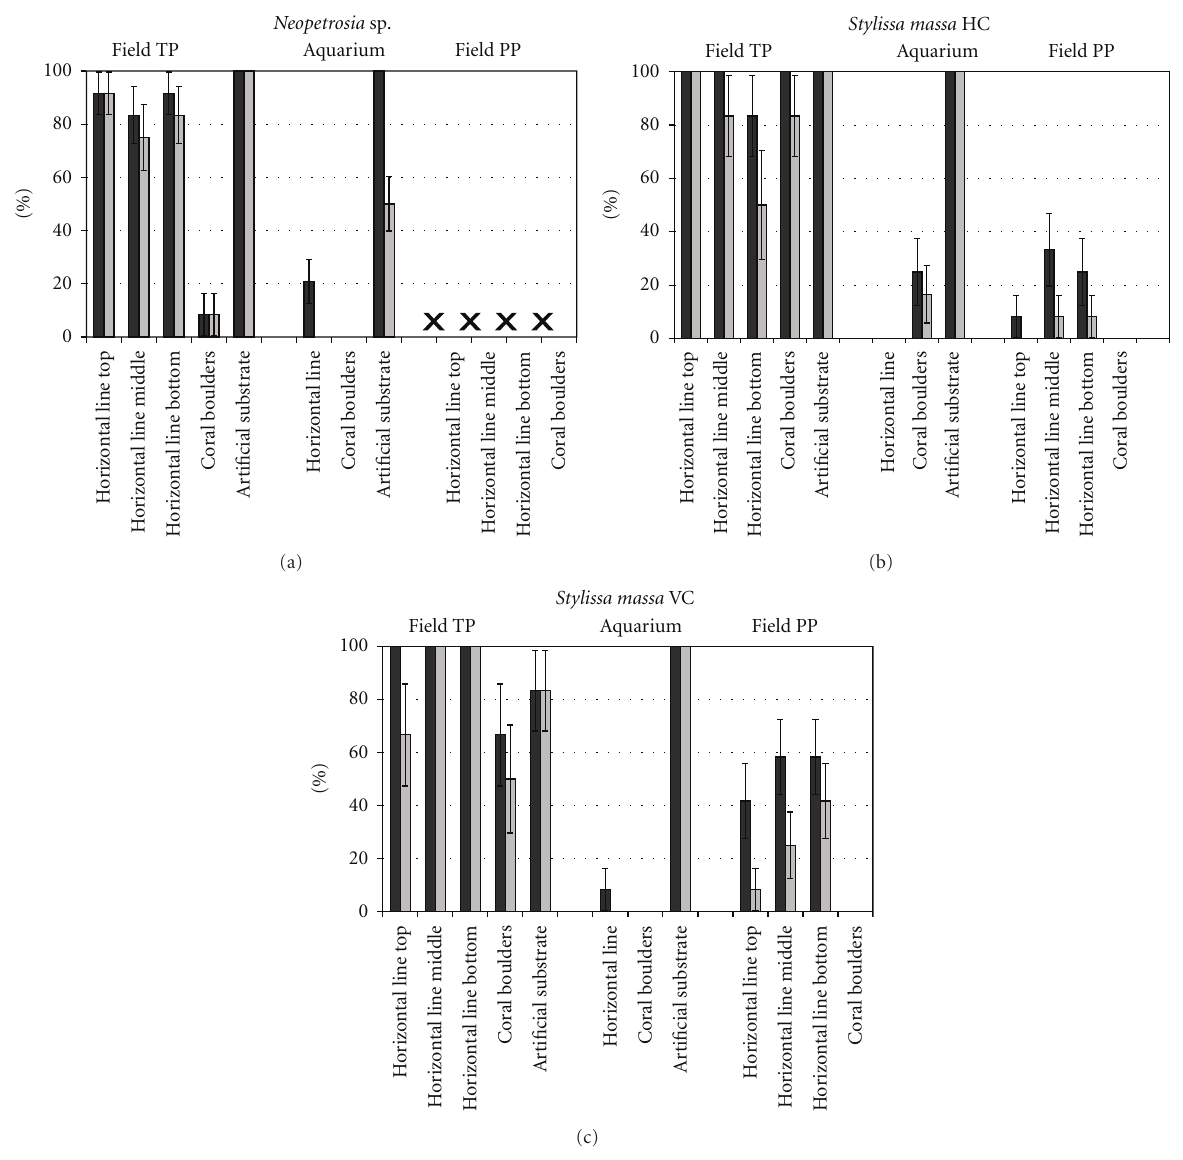
Figure 8: Mean final percentage survival and attachment in the end of the study for di ff erent methods. Error bars represent the standard deviation between fragments of specific methods. (X: no fragments were planted, TP: Teluk Pegametan, PP: Pulau Pari, HC: horizontally cut, VC: vertically cut, thl: top horizontal rope, mhl: middle horizontal rope, bhl: bottom horizontal rope, lr: coral boulders, as: artificial substrate, and hl: horizontal